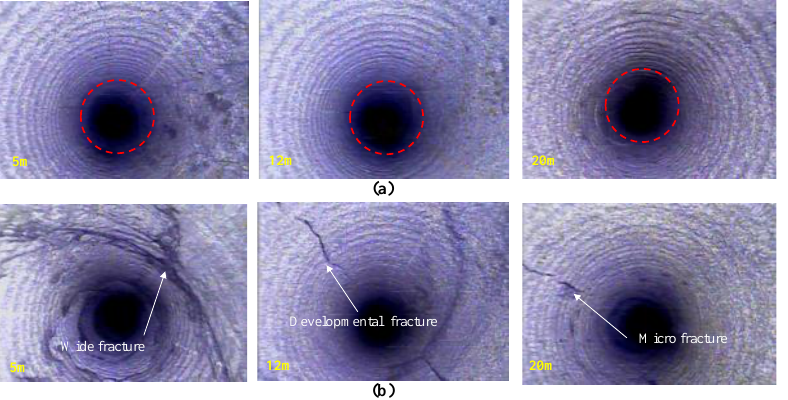
Figure 20. Drilling peep results before and after hydraulic fracturing: ( a ) before fracturing; ( b ) after fracturing.